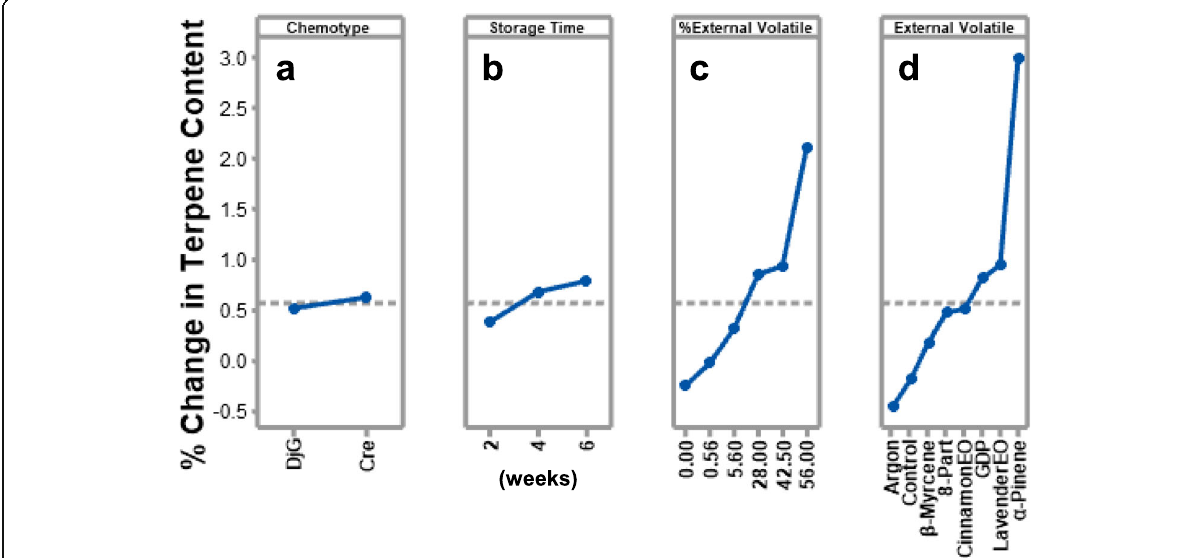
Fig. 4 Main effects plot evaluating the impact of each variable on the system ’ s effectiveness towards terpene preservation. a Chemotype of inflorescence b storage time of inflorescence c percent external volatile relative to inflorescence d different external volatiles utilized, GDP = Granddaddy Purps terpene